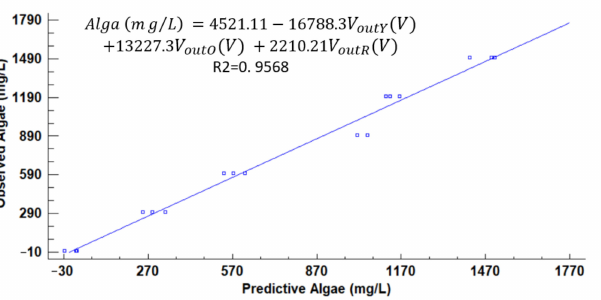
Figure 17. Observed vs. predicted values of algae concentration with a solid concentration of 1500